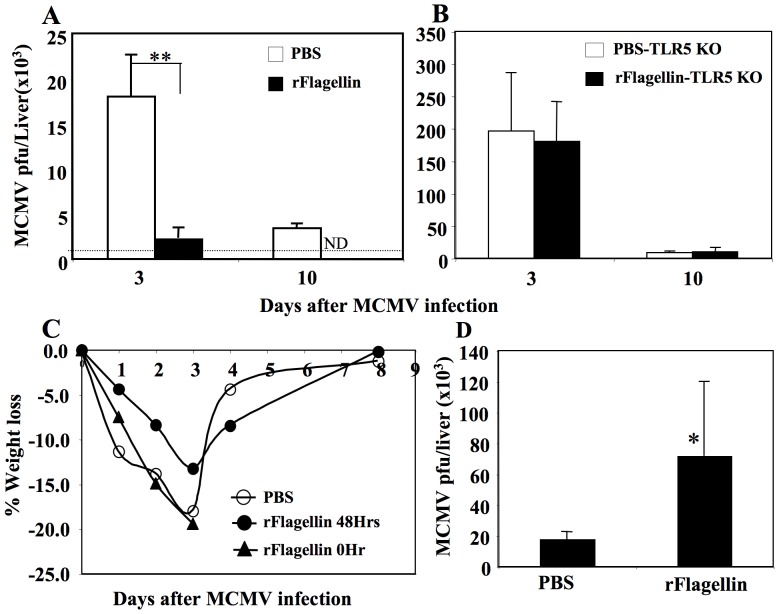
Prophylactic rflagellin administration reduced liver mCMV load in WT B6 mice.WT B6 and TLR5 KO B6 mice were given 25 µg rflagellin or 0.2 ml PBS i.p 48 hours before a sub-lethal dose (1×105 pfu/mouse i.p) of mCMV. Mice were sacrificed on day 3 and 10 after mCMV infection and viral load per liver was determined as described in Materials and Methods. A. Virus titer in livers of rflagellin- and PBS-treated WT B6 mice. B. Virus titer in livers of rflagellin- and PBS-treated TLR5 KO B6 mice. The data are the representative of three similar experiments using 5 mice per group at each time point. C. WT B6 mice were given 25 µg rflagellin/mouse (rFlagellin 48 Hrs, closed circle) or 0.2 ml PBS (open circle) i.p 48 hours before or at the same time as (rFlagellin 0 Hr, closed triangle) a sub-lethal mCMV infection (1×105 pfu/mouse i.p). Weights of individual mice were measured on day 0, 1, 2, 3, 4 and 8 days after mCMV infection. Percent weight changes per group of experimental mice are presented. D. Mice receiving rflagellin (rFlagellin 0 Hr) during mCMV infection became dehydrated and hunched and were sacrificed on day 3 after mCMV infection and liver viral load was determined. The data are the representative of two similar experiments using 5 mice per group. The symbols “*” and “**”represent the p values<0.05 and <0.005, respectively, Students t-Test.